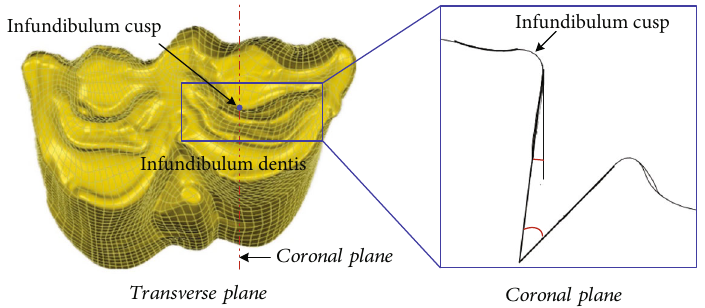
Figure 2: Extraction of biological coupling elements of bovine molar.